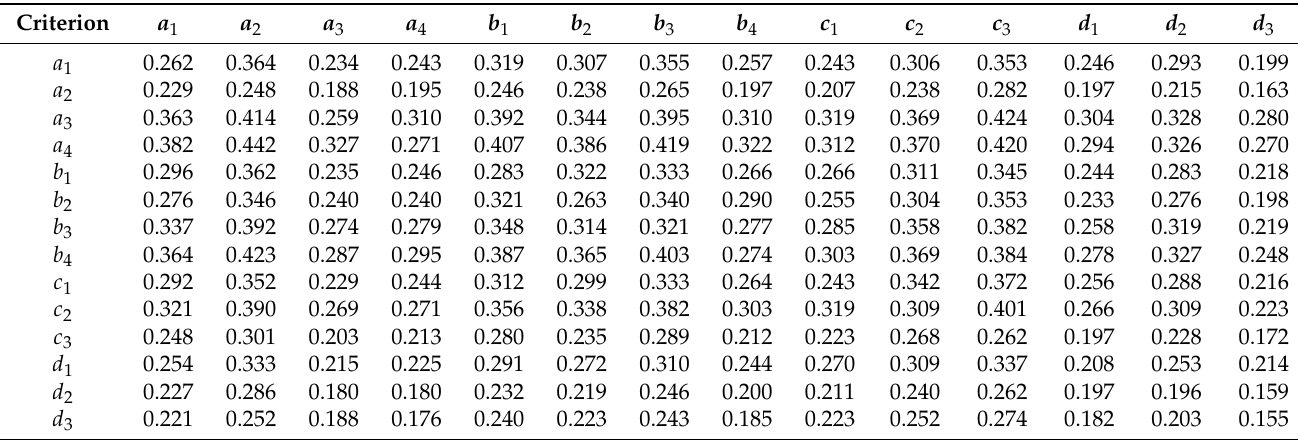
Table 7. Fuzzy normalized direct and indirect influence relation matrix T r